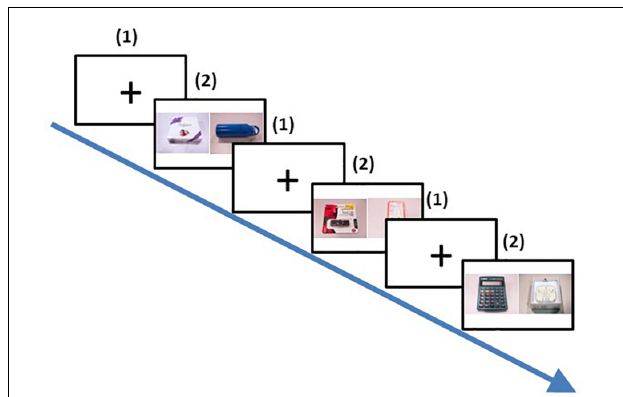
FIGURE 2 | Trial procedure of the pairwise choice task (third phase). (1) A fixation screen was displayed for 1 second; (2) Two pictures of the two products were presented side by side for 3 s. Participants had to choose with a key press which of the the two products they preferred. This procedure was repeated for all possible pairs of the products and repeated 7 times, resulting in 462